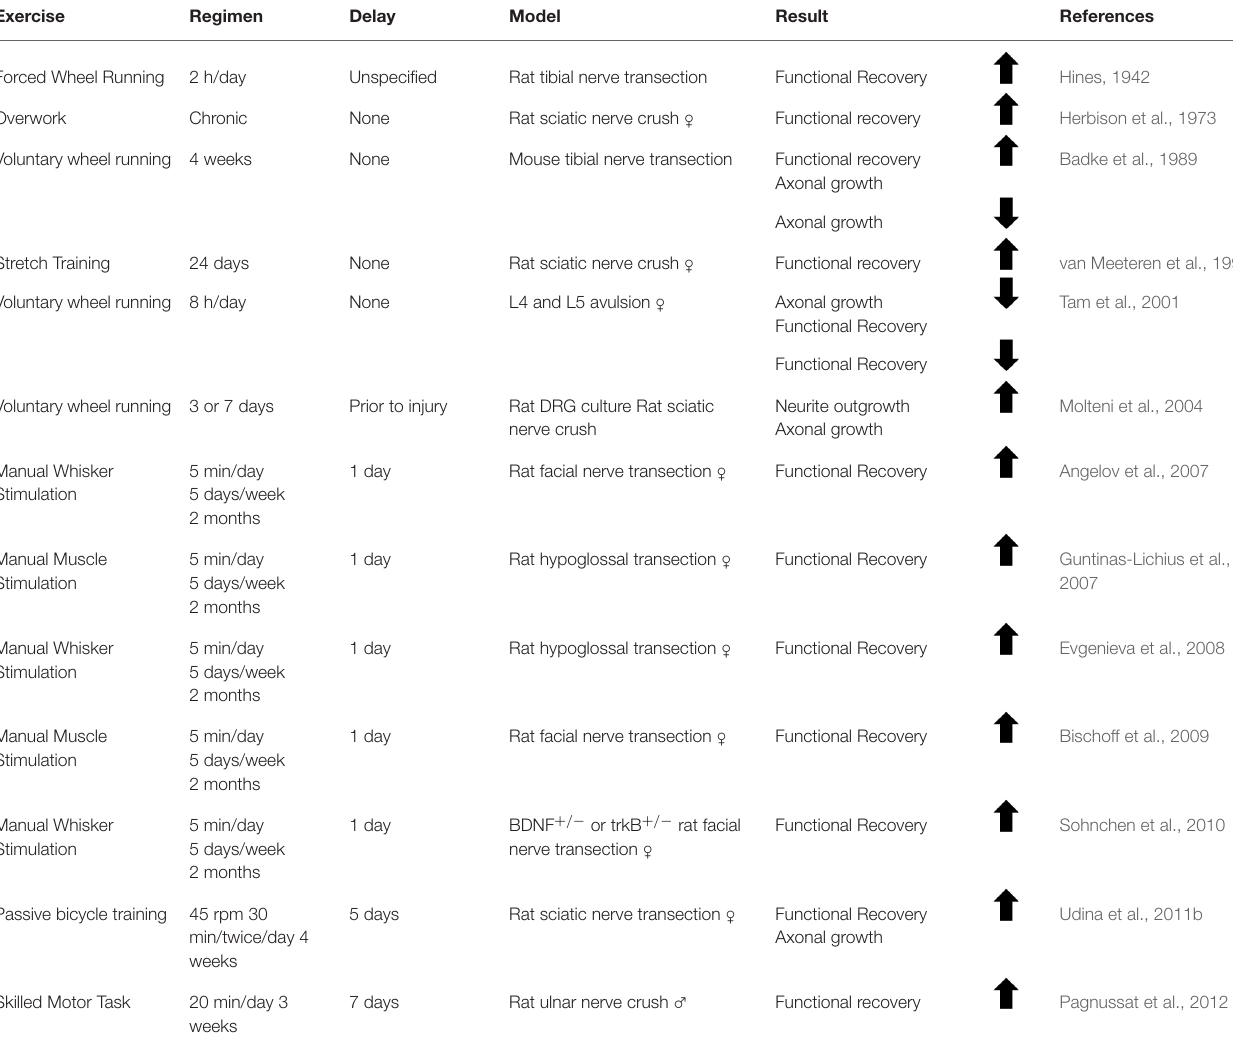
TABLE 4 | Effect of other exercise paradigms on peripheral nerve